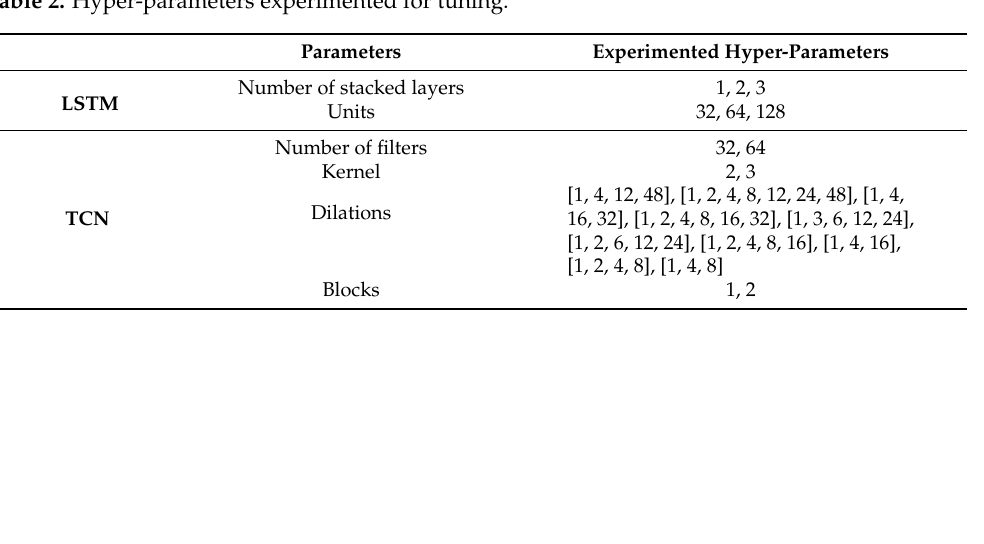
Table 2. Hyper-parameters experimented for